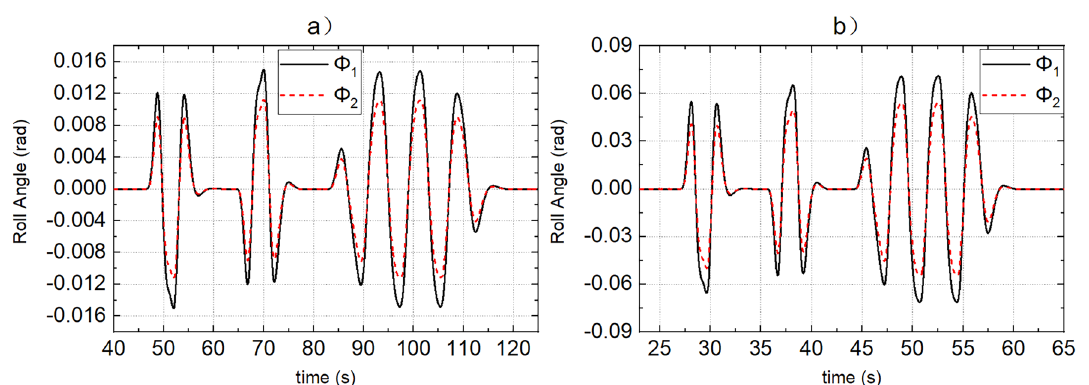
Figure 11. ( a , b ) Show the actual roll angle when the road adhesion coefficients are 0.15 and 0.8, respectively. Curve 1 represents the SCS effect, and curve 2 represents the MMCCS effect.